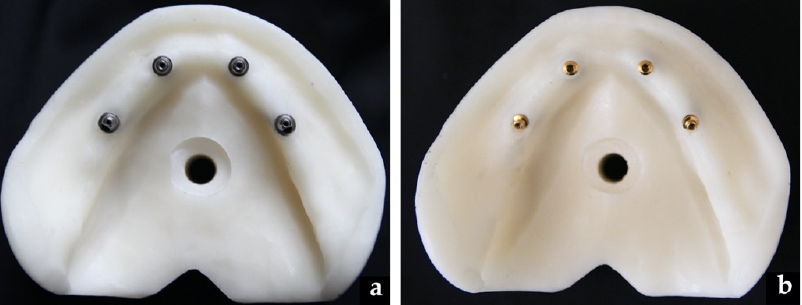
Figure 1. ( a , b ). Edentulous model with Multi Unit Abutment system ( a ) and OT-Equator abutment system ( b ).